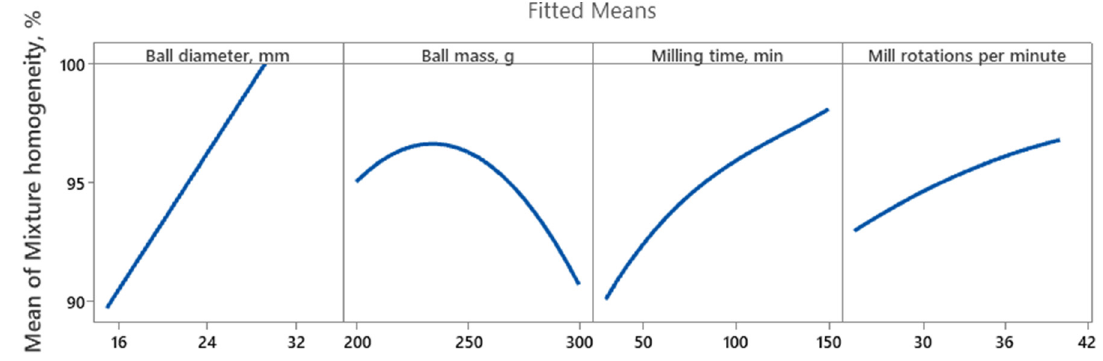
Figure 2. Main effects plot for mixture homogeneity.